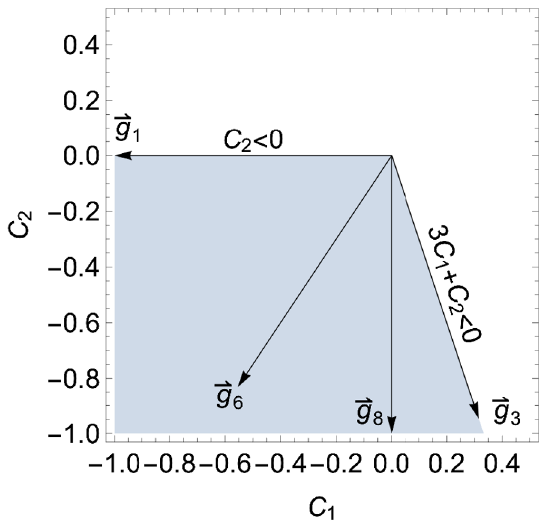
Figure 7. Positivity cone for right-handed up/down-quark operators, together with the